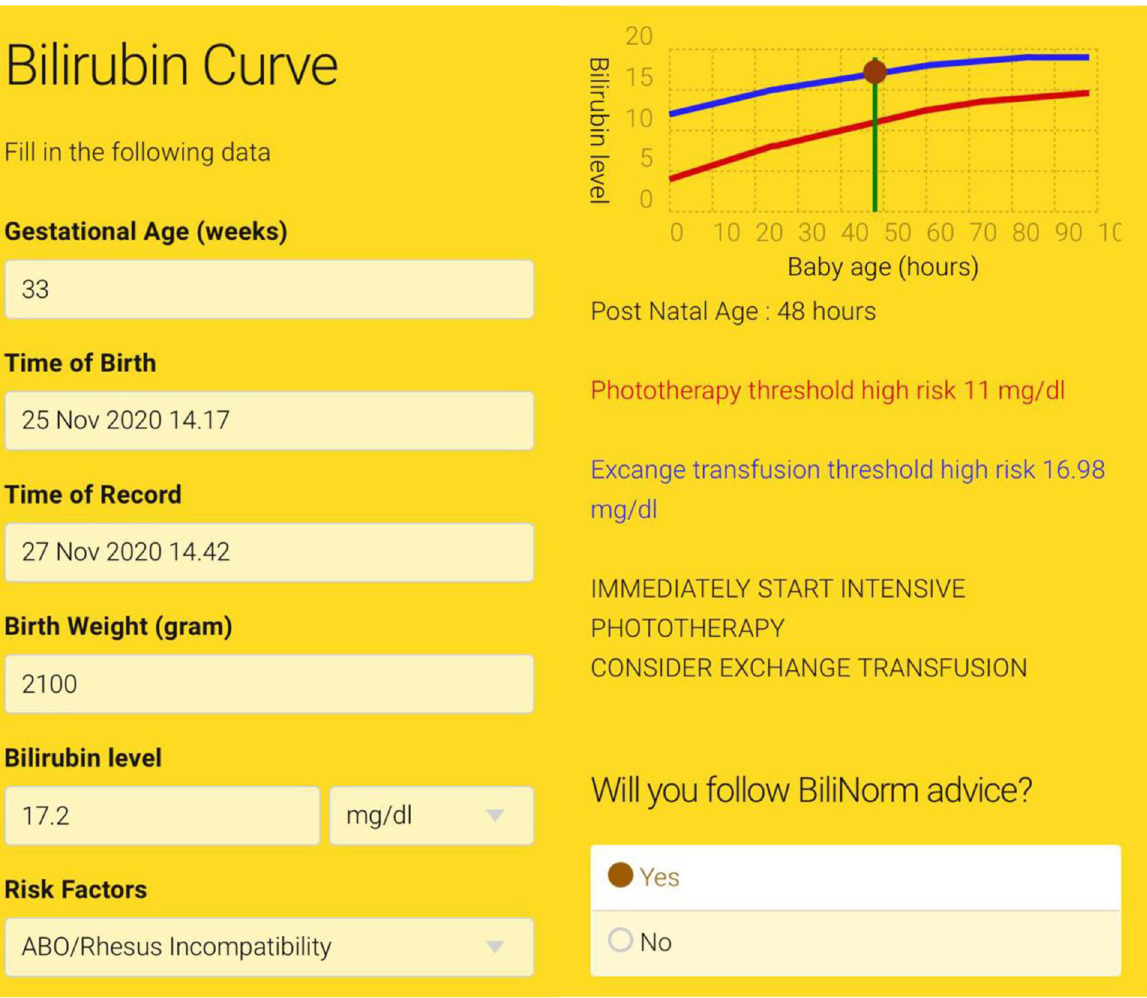
Fig 1. BiliNorm application algorithm. (ABE = Acute Bilirubin Encephalopathy, BIND-M = Bilirubin-Induced Neurological Dysfunction-Modified, KSD = Kernicterus Spectrum Disorder, NICE = National Institute for Health and Care Excellence).